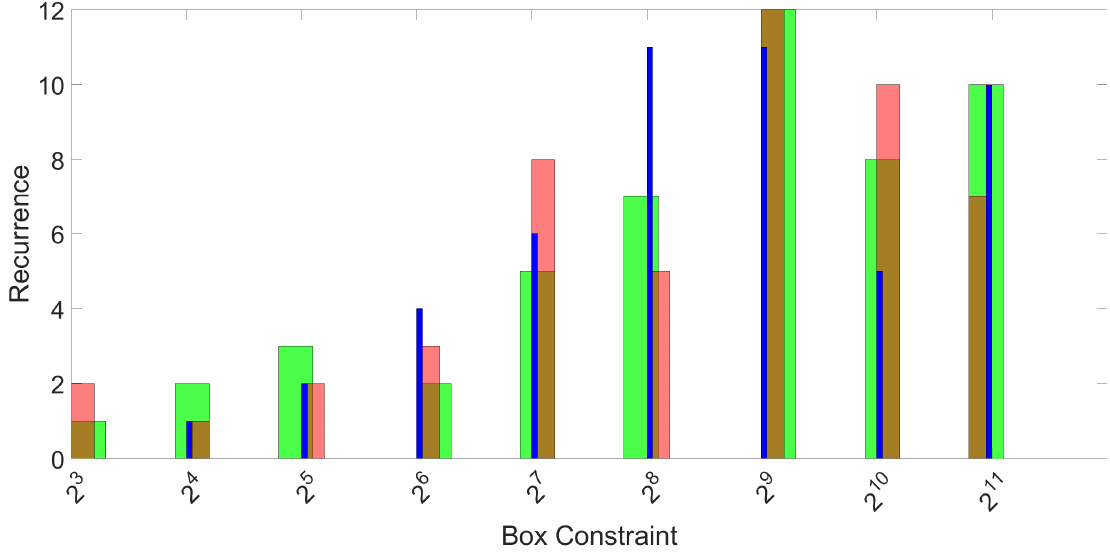
Figure 8. Histograms of the recurrence of the best performing box constraint parameter C for 50 repetitions and three folds. The three colors represent the three